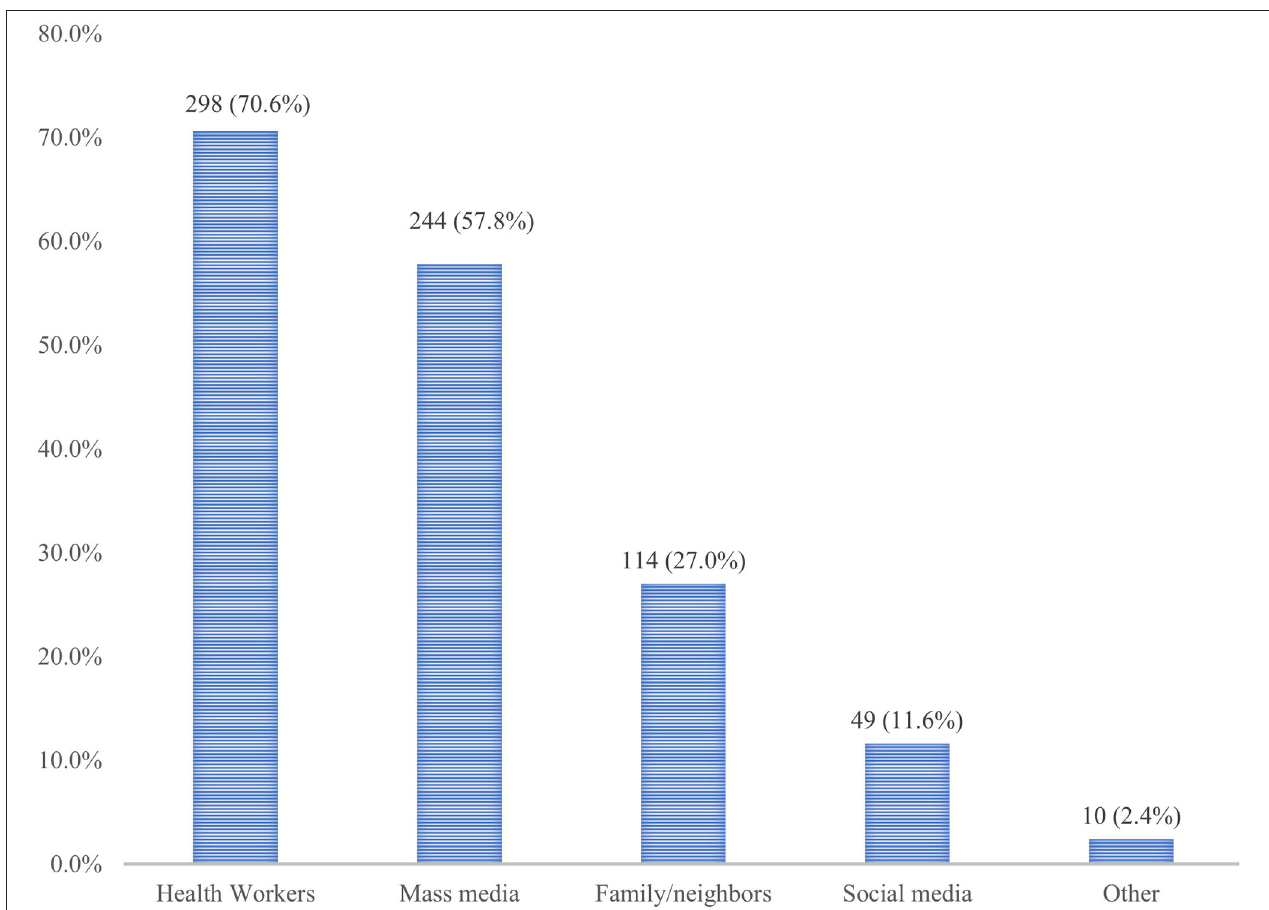
FIGURE 2 | Source of information regarding breastfeeding among pregnant women attending MCH clinic of DTCSH in Debre Tabor, Northwest Ethiopia,